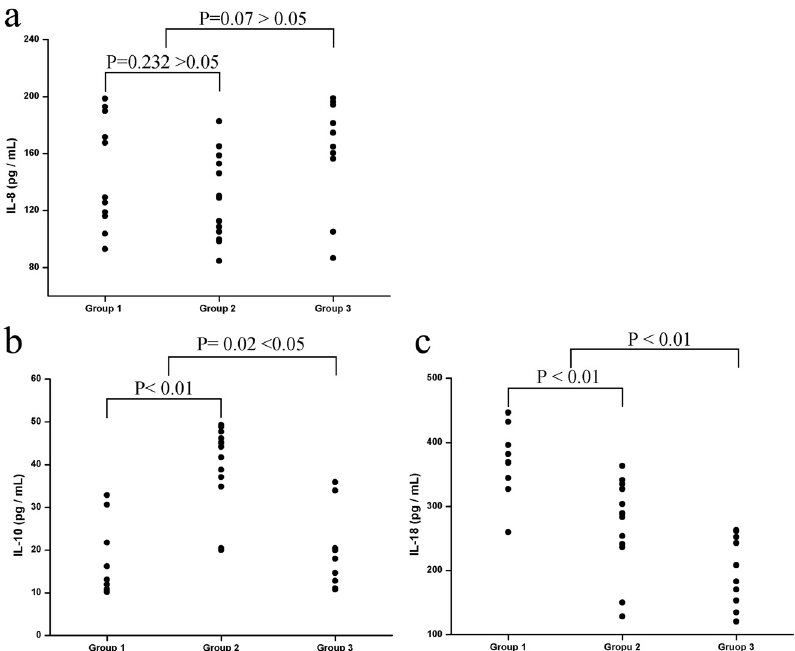
Fig 1. IL-8 (a), IL-10 (b) and IL-18 (c) levels in non-asthmatic patients with severe M . pneumoniae pneumonia (group 1) and mild M . pneumoniae pneumonia (group 2), and in asthmatic patients with M . pneumoniae pneumonia (group 3). Serum IL-10 and IL-18 levels were significantly higher in patients infected by M . pneumoniae without asthma than those in group 3. However, IL-8 levels were not significantly different. Serum IL-10 levels were significantly lower in group 1 than in group 2, while IL-18 levels were significantly higher in group 1; IL-8 levels were not significantly